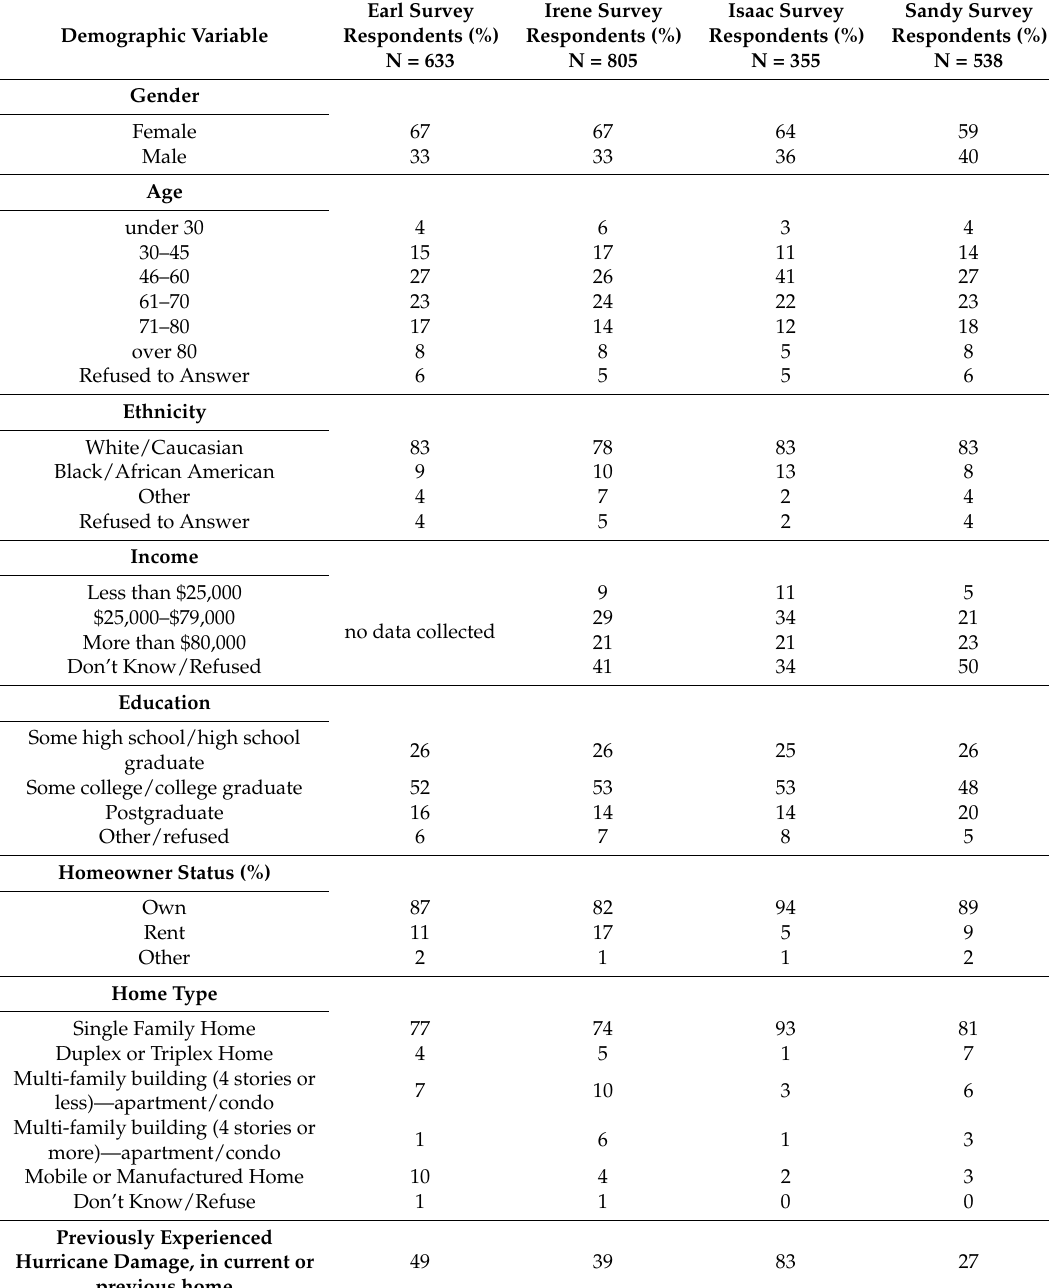
Table 1. Demographics for the four